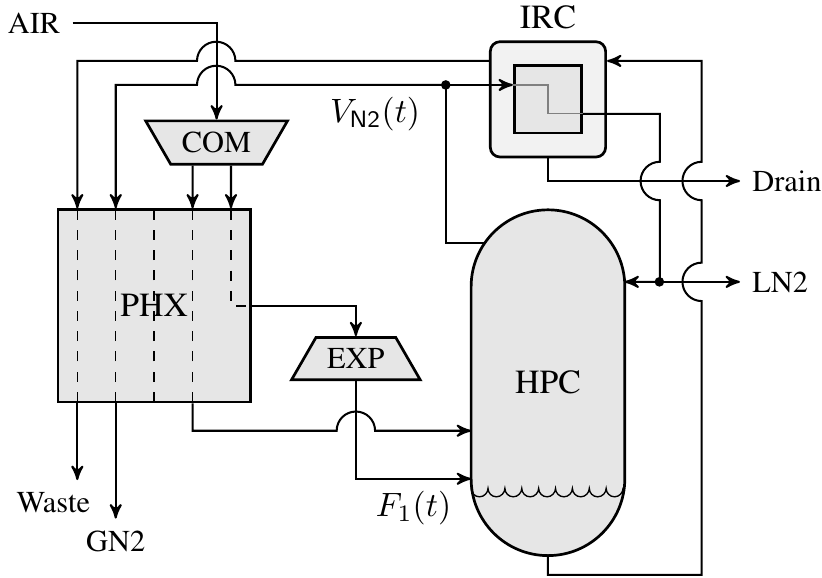
Figure 4. Case Study 2: air separation process